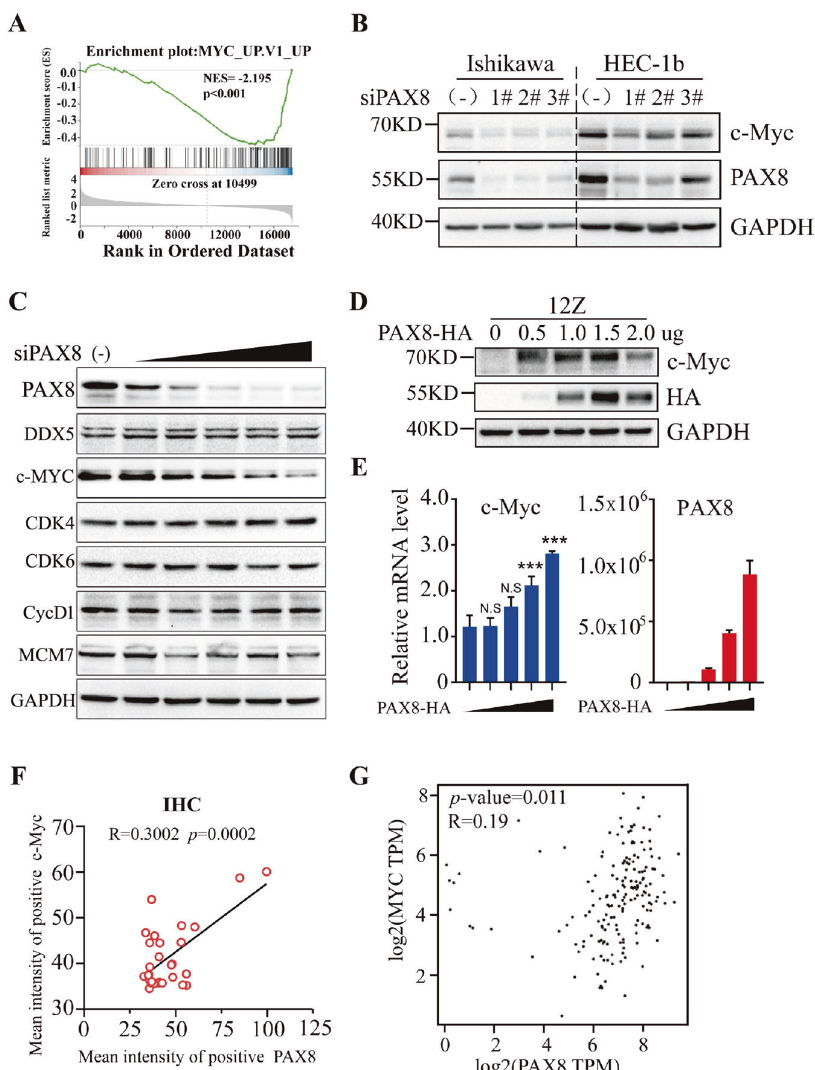
Fig. 4 C-MYC gene activation is responsible for PAX8 overexpression in UCEC. A Representative enrichment plots of the c-MYC-related gene set which negatively correlate with siPAX8 in Ishikawa cell. B PAX8 expression was knocked down by siRNA transfection, cells were collected 48 h after transfection, the expression level of PAX8 and c-MYC proteins in Ishikawa and HEC-1B cells were detected by Western blotting. C After gradient knockdown of PAX8 in Ishikawa cells, the expression level of PAX8 and cell cycle-related proteins were detected by Western blotting. D , E PAX8 was overexpressed by transfected HA-PAX8 plasmid (0ug, 0.5ug, 1ug, 1.5ug, 2ug) in 12Z cells, after 48 h transfection, total RNA and total protein were extracted from cells for qPCR and Western blot analysis, respectively. F Linear regression and correlation of PAX8 versus c-MYC protein level. R value is Pearson ’ s correlation coef fi cient. G The mRNA expression level of c-MYC was positively correlated with PAX8 in GEPIA. N.S. not signi fi cantly different among the groups by Student ’ s t-test. * p < 0.01, ** p < 0.005, *** p <